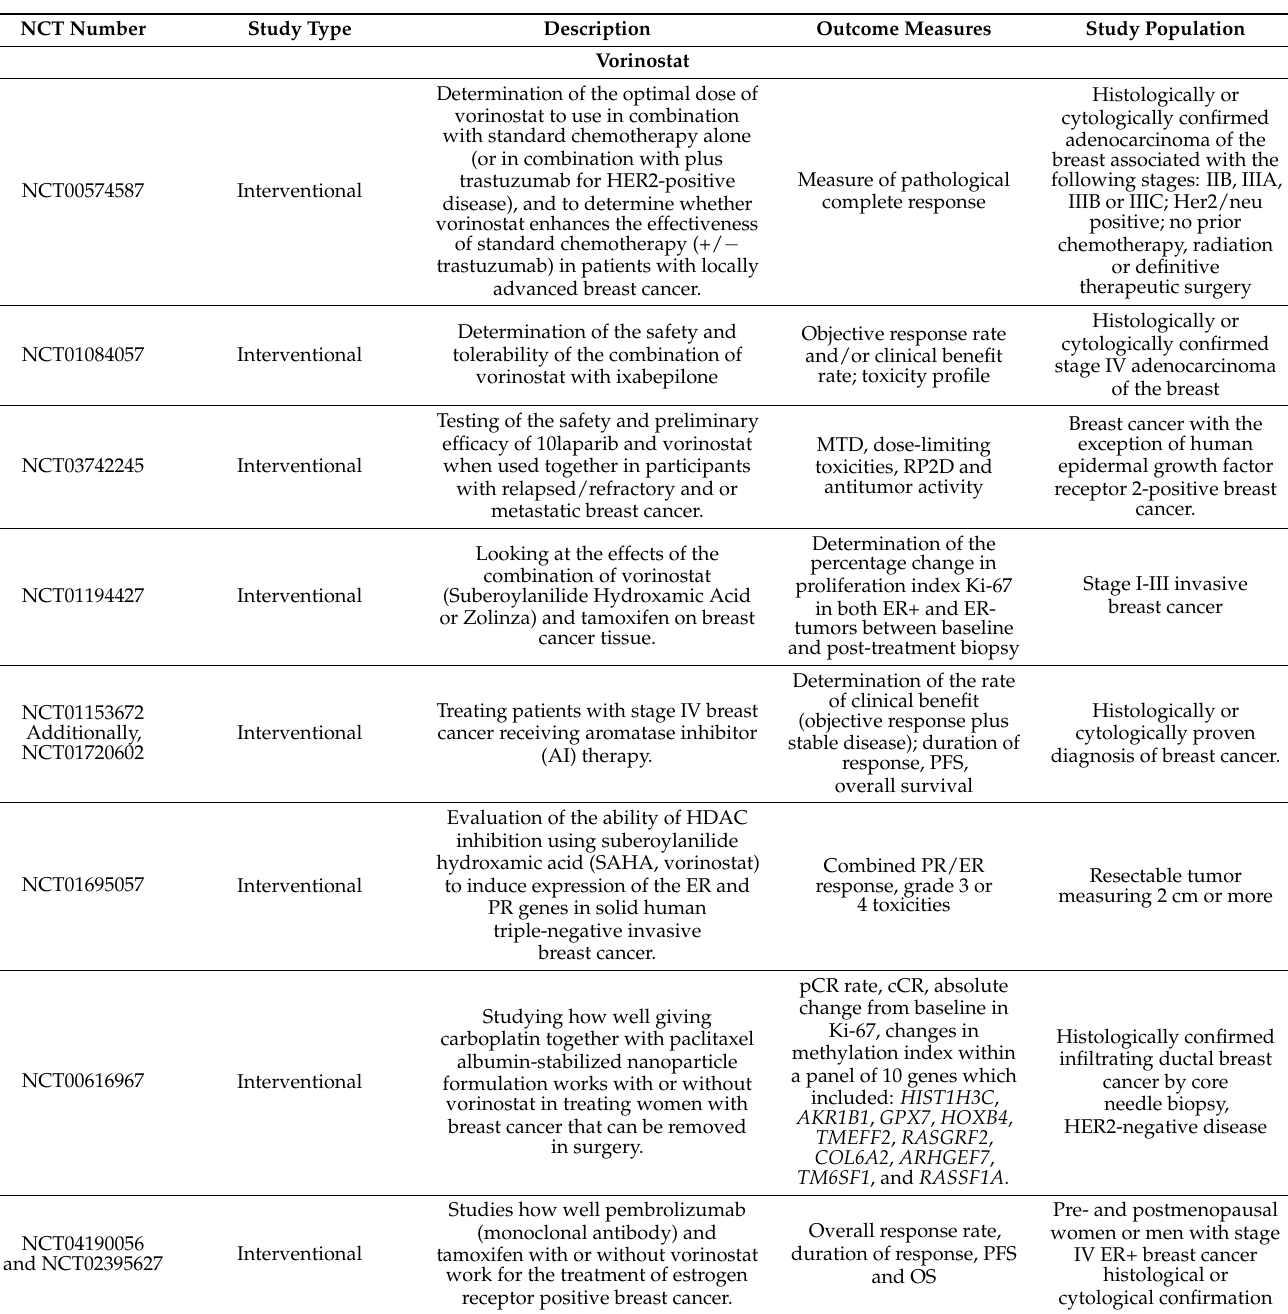
Table 2. Exemplary clinical studies on the role of histone deacetylase inhibitors in breast cancer (based on ClinicalTrials.gov (accessed on 5 March 2023)